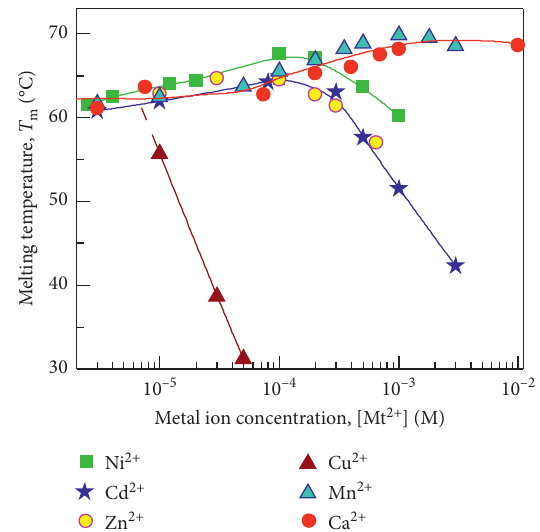
Figure 4: Dependence of the melting temperatures ( T C) on the Mt 2+